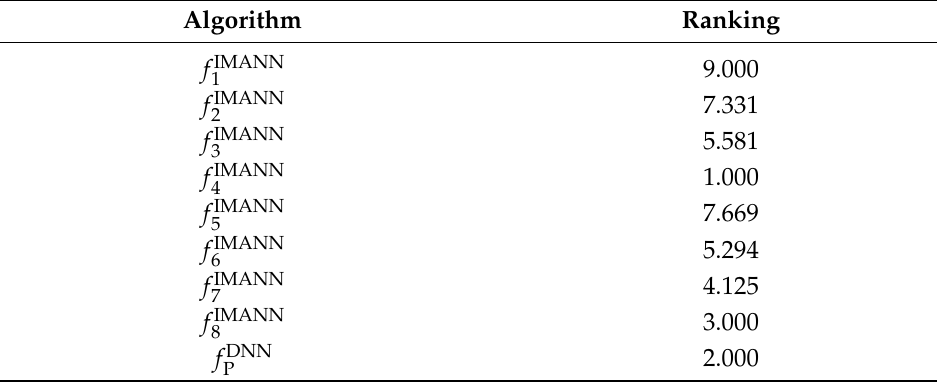
Table 2. Average rankings of the algorithms (Quade).